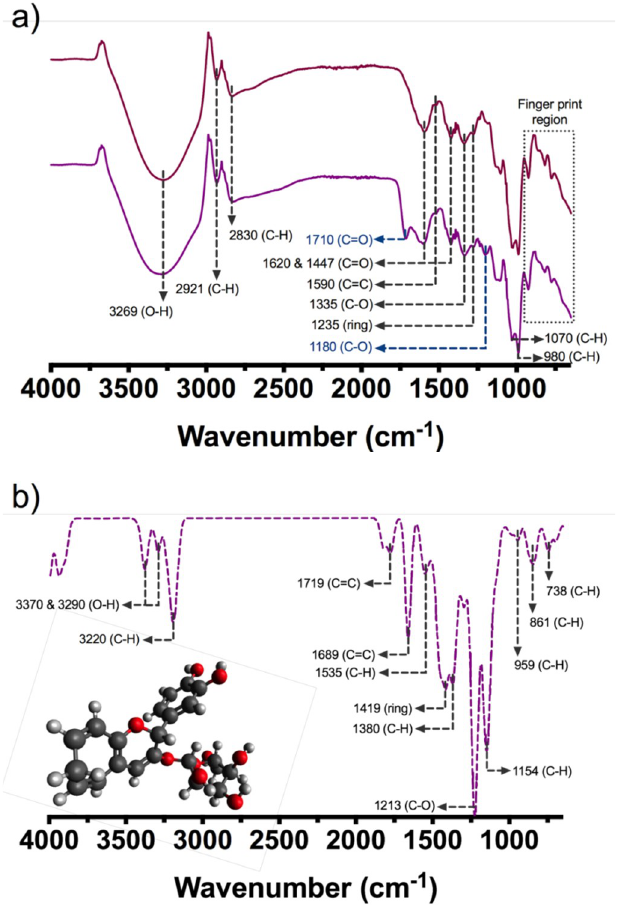
Figure 1. ( a ) Experimental FTIR spectra of black carrot extracts; samples extracted with ethanol/citric acid (BCS) and ethanol/acetic acid (BCA), ( b ) Simulated FTIR spectra using B3LYP calculation and cyanidin 3-O-glucoside molecule (used for simulation).